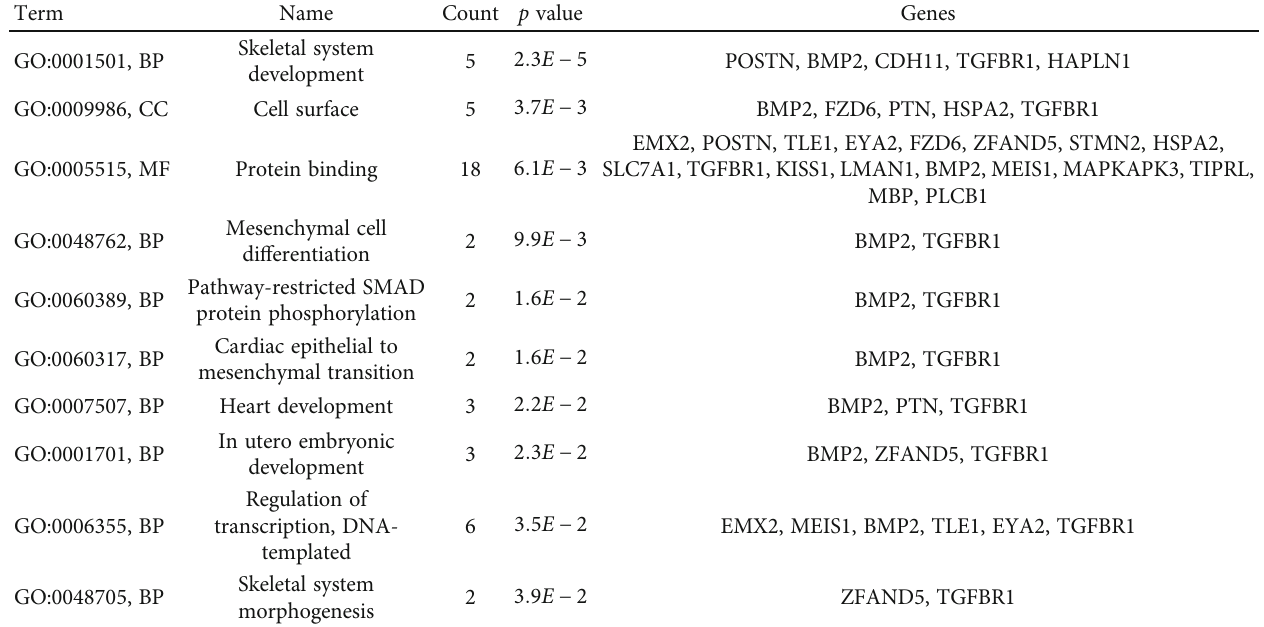
Table 1: Functional enrichment analysis of the DEGs. Top 10 terms were selected according to p value.